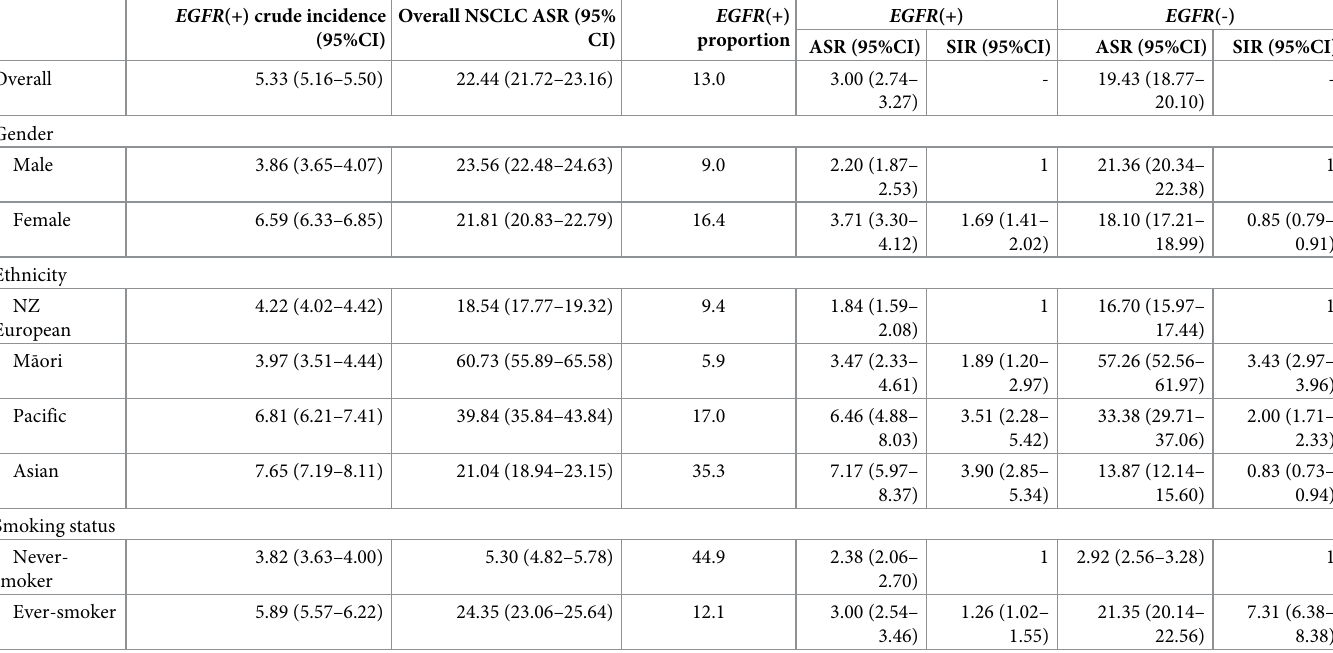
Table 3. Incidence rates of non-squamous non-small cell lung cancer by EGFR mutation status, showing the estimates for 100%